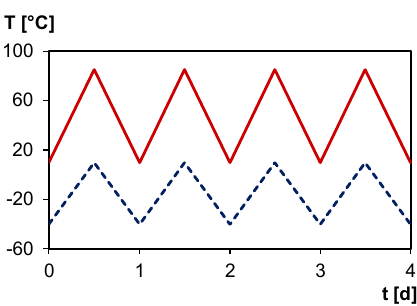
Figure 16. Typical daily temperature cycle in summer ( full red line ) and in winter ( dashed blue line ).